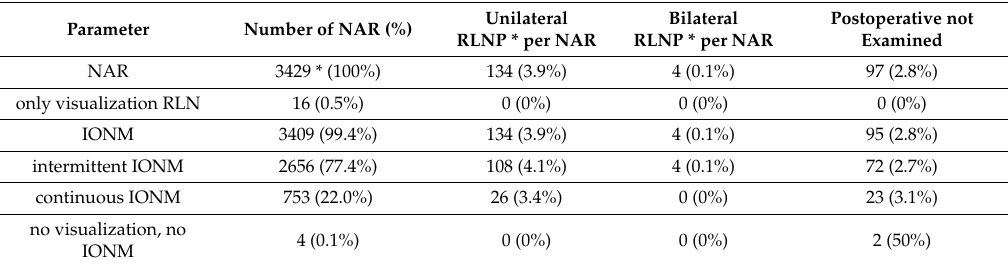
Table 4. Use of IONM (intraoperative neuromonitoring) and the rate of RLNP (recurrent laryngeal nerve palsy) per NAR (nerves at risk) in patients with